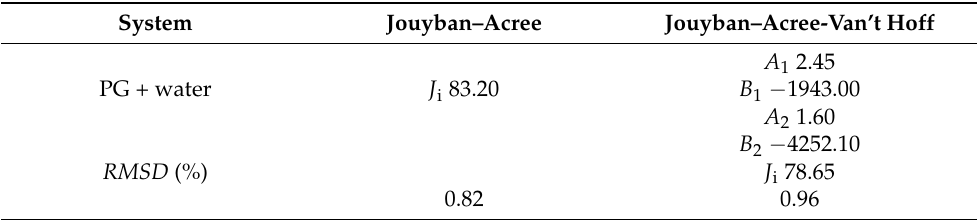
Table 11. The results of the Jouyban–Acree and Jouyban–Acree–van’t Hoff models for TRV in PG + wa- ter